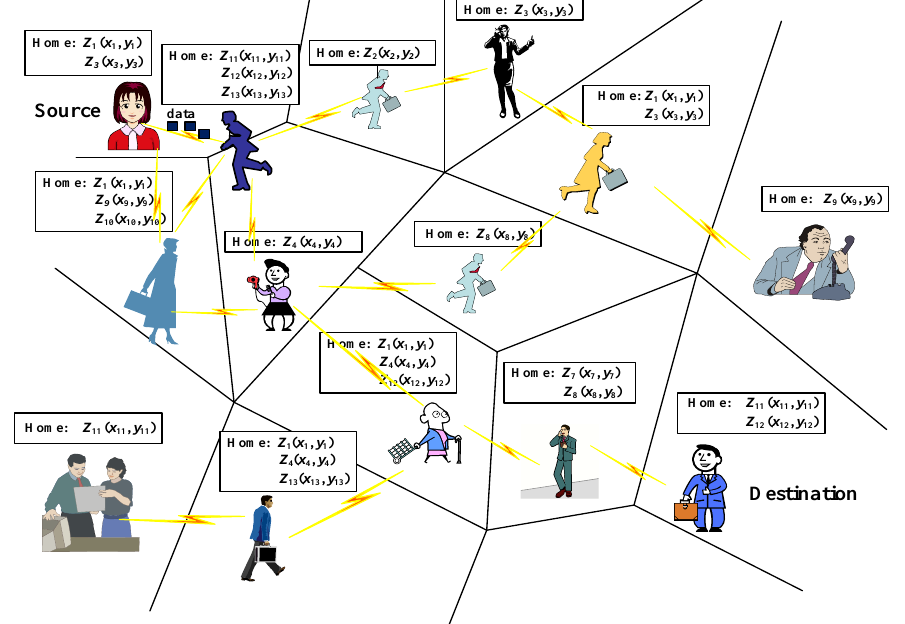
Figure 2. The HERO framework. In the framework, the whole network is divided into multiple non-overlapping zones which are identified by its center